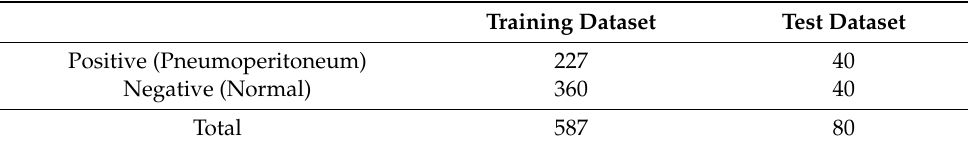
Table 1. Train–test split for the chest X-ray